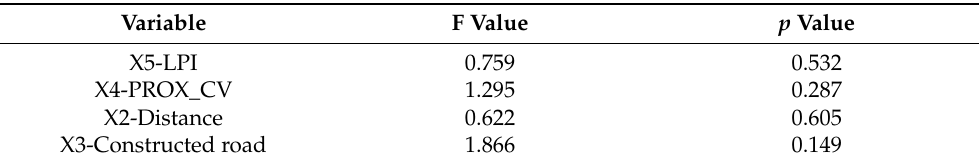
Table 3. p values from ANOVA test of the spatial variables for the locations in the different latitudes